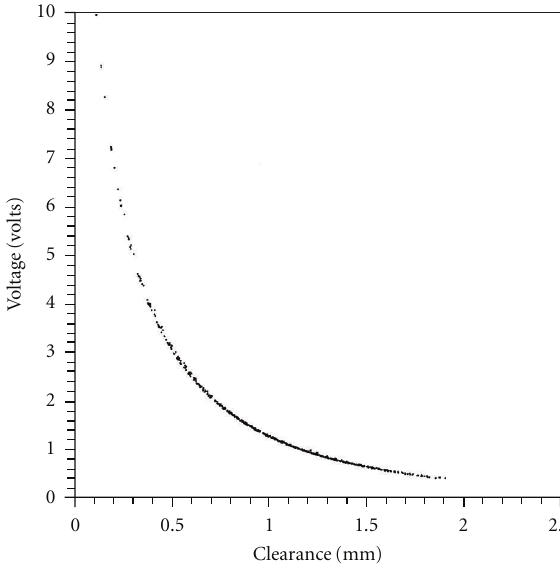
Figure 15: FM capacitance probe output for the longest blade of the spinning rig wheel plotted against known position, which was changed using the traverse